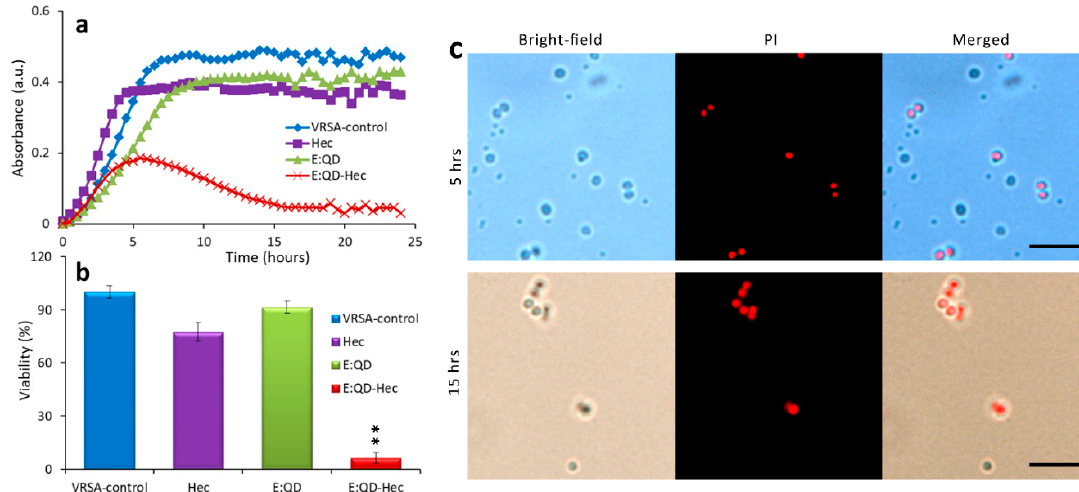
Figure 7. Antibacterial property of the QD-peptide conjugate. ( a ) Growth curve analysis of VRSA. The growth of the bacteria is represented in terms of absorbance (a.u.). ( b ) Bacterial cell viability after 24 h of incubation. The viabilities of the samples are represented here as the percentage of VRSA-control (only the bacteria that were incubated without Hec or E:QDs). Hec, E:QD, and E:QD-Hec denote the bacterial samples incubated with only the peptide, only E:QDs, and E:QD-peptide conjugate, respectively. Data represent the mean ± SD, n = 5. ( c ) Bright-field and fluorescent microscopic images of VRSA after 5 and 15 h of treatment with E:QD-Hec. The dead cells are seen as red fluorescence from propidium iodide (PI). The scale bar is 5 µM. Data represent the mean ± SD of the mean of three individual experiments. * p < 0.01 or ** p < 0.001.